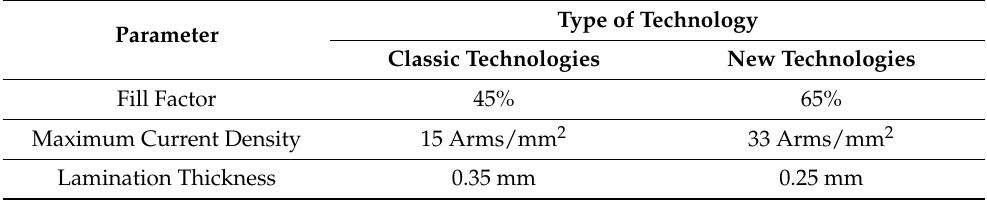
Table 4. Parameters value of both classic and new